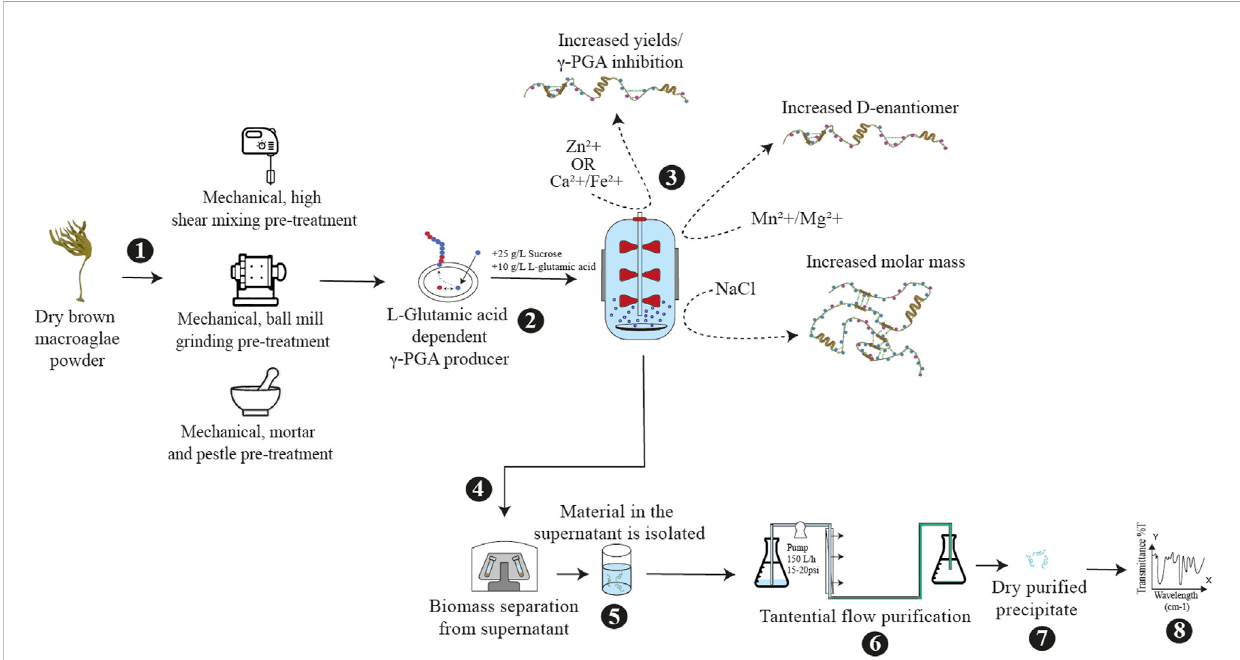
FIGURE 1 Schematicbiosynthesisofcultivatedbrownmacroalgaefor γ -PGAbiosynthesis.[1]drymacroalgaeissubjectedtomechanicalpre-treatment[2]the pre-treated macroalgae biomass is supplemented with sucrose and glutamic acid; followed by inoculation with a bacterial γ -PGA producer [3] the fermentation media can be supplemented with modulatory compounds, [4] isolation of γ -PGA by centrifugation occurs and [5] γ -PGA is precipitated in ethanol. [6,7] the precipitate is then re-dissolved for further puri fi cation [8] followed by freeze